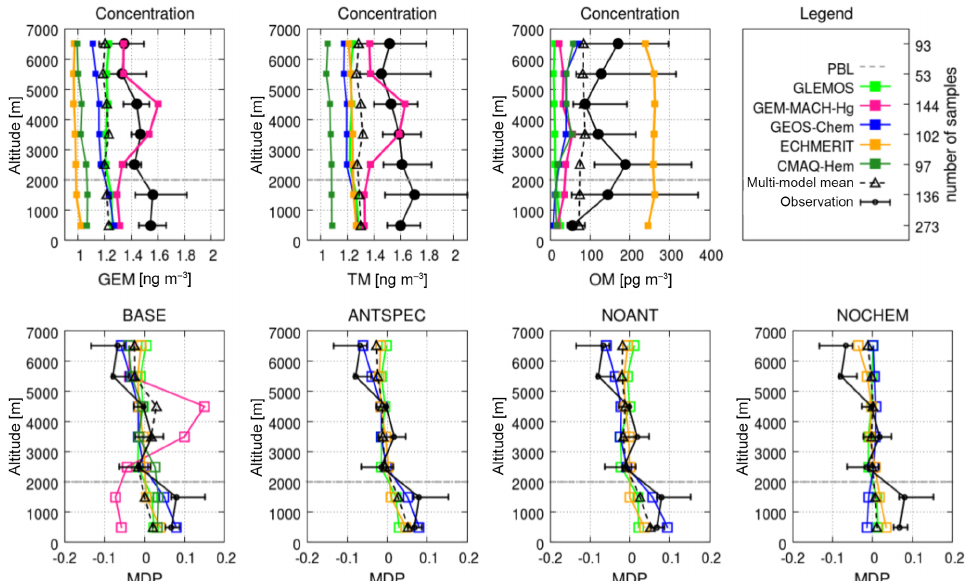
Figure 5. Comparison of modelled average mercury profiles for North America to observations based on NOMADSS flights in June and July 2013 (Shah et al., 2016; Gratz et al., 2016). The error bars indicate the 66% quantile range of the observations in each altitude; the sample size for each altitude is indicated on the y axis of the legend. The mean deviation profiles (MDP) are given for TM.